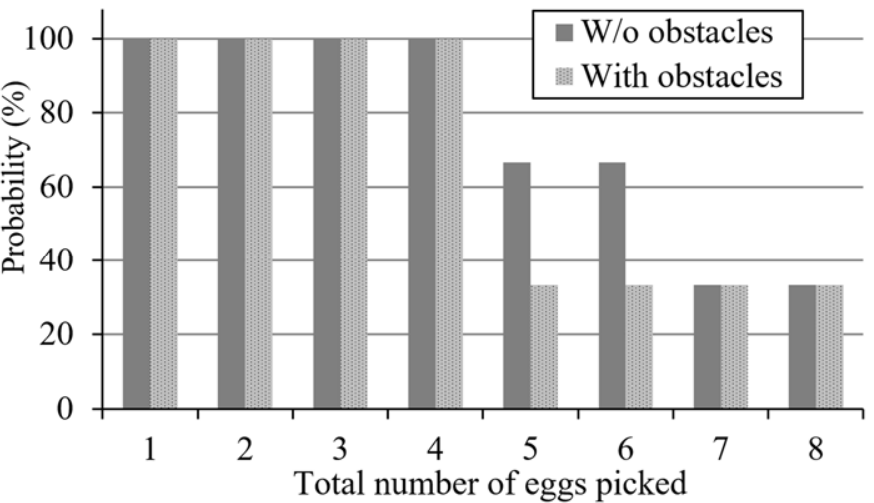
Figure 16. Probability of egg collection within a limited collection time of 5 min.